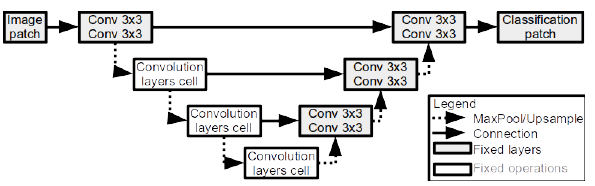
Figure 4. Architecture search space in this research.